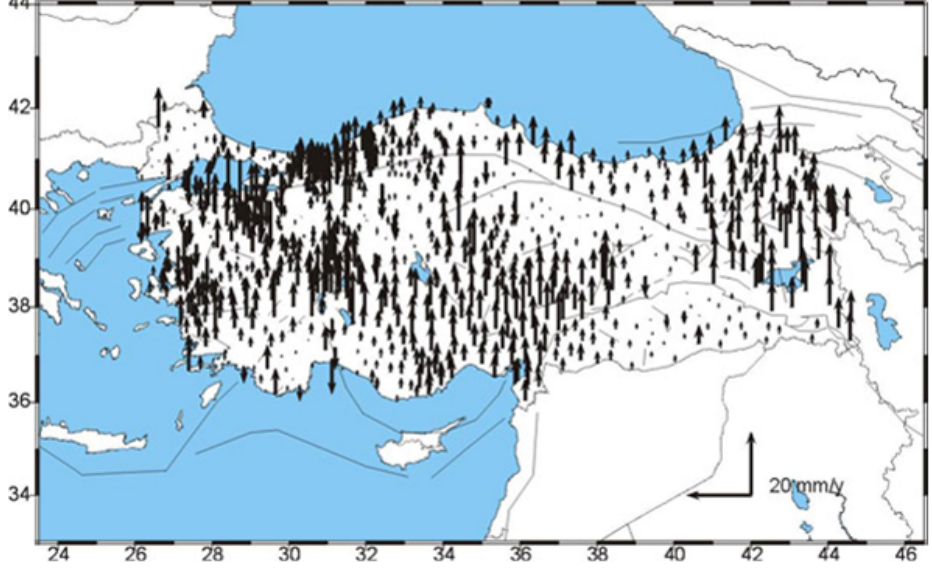
Fig. 3b. Vertical velocity vectors of the stations within the TUTGA network estimated using GPS observations (Ayhan et al., 2001b).